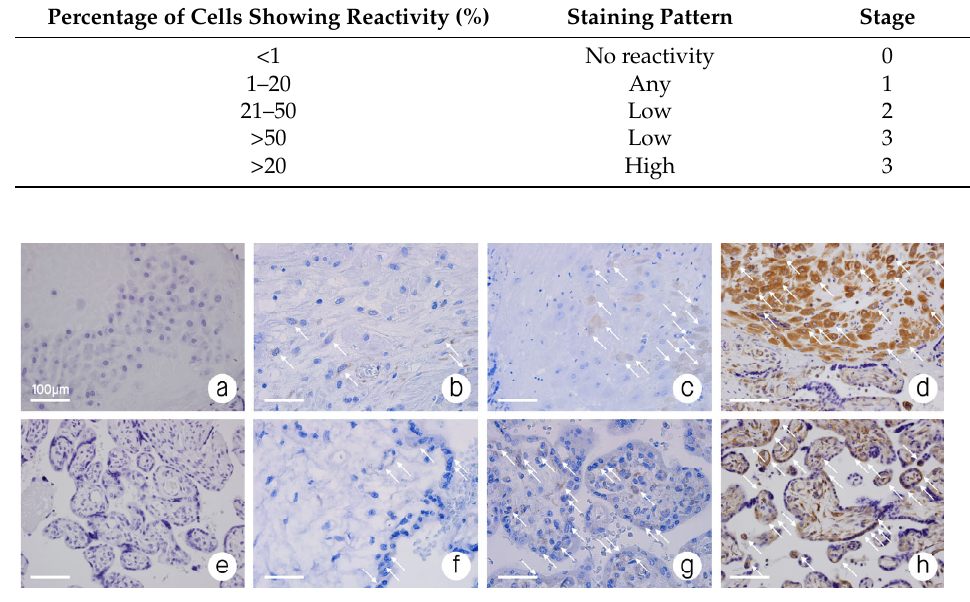
Figure 1. B7 ‐ H4 immunoreactivity; ( a ) decidua–stage 0–no B7 ‐ H4 immunoreactivity; ( b ) decidua– Figure 1. B7-H4 immunoreactivity; ( a ) decidua–stage 0–no B7-H4 immunoreactivity; ( b ) decidua–